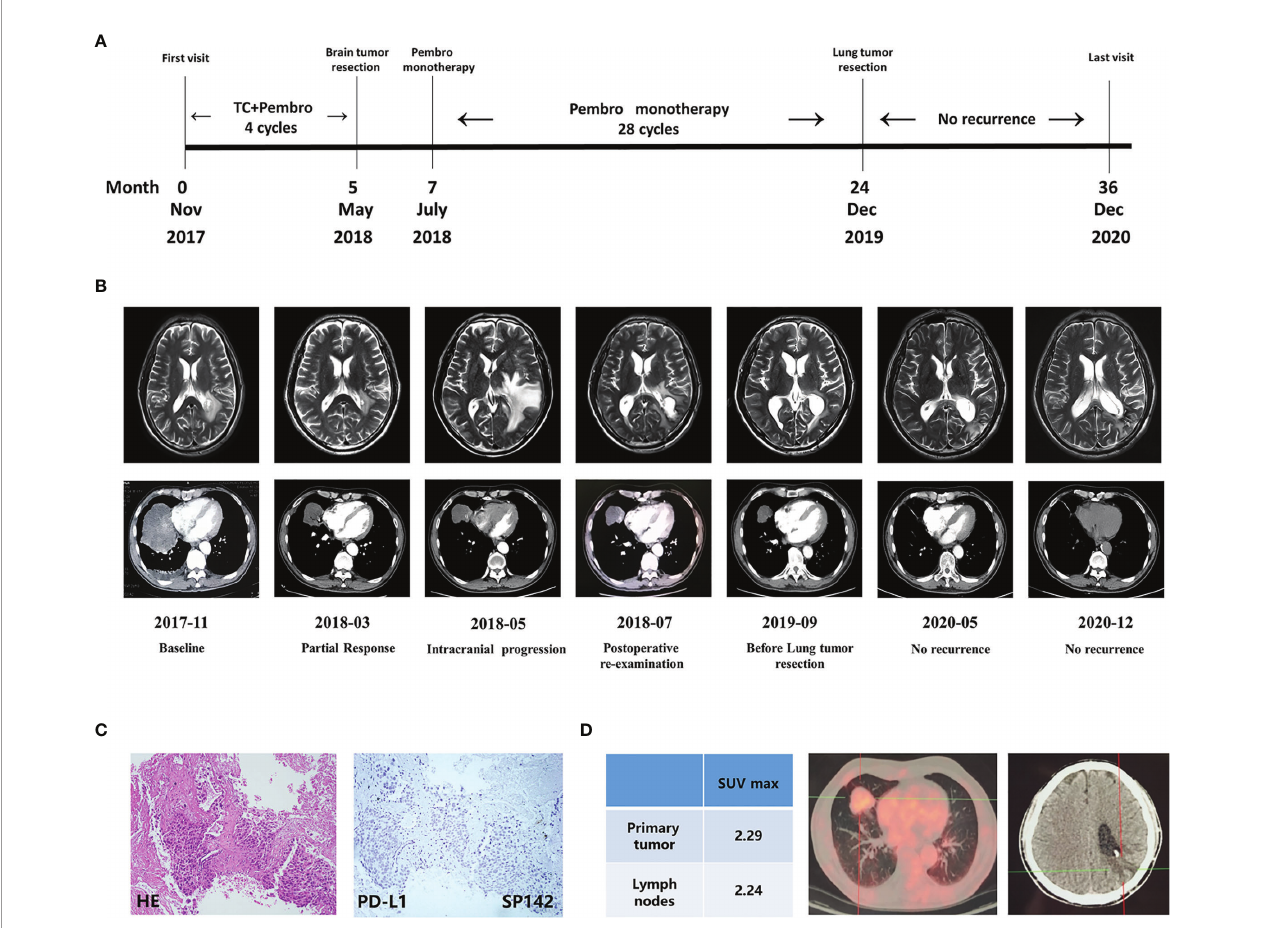
FIGURE 1 | Clinical response to long-term immunotherapy and the effect of surgery. (A) Schematics showing the time line of patient ’ s diagnosis, treatment and response. (B) Computed tomography scans and Magnetic resonance imaging showing clinical response to immunotherapy and the effect of surgery. (C) The result of PD-L1 staining before immunotherapy. (D) PET-CT scan before Lung tumor resection. TC, paclitaxel+carboplatin; Pembro,